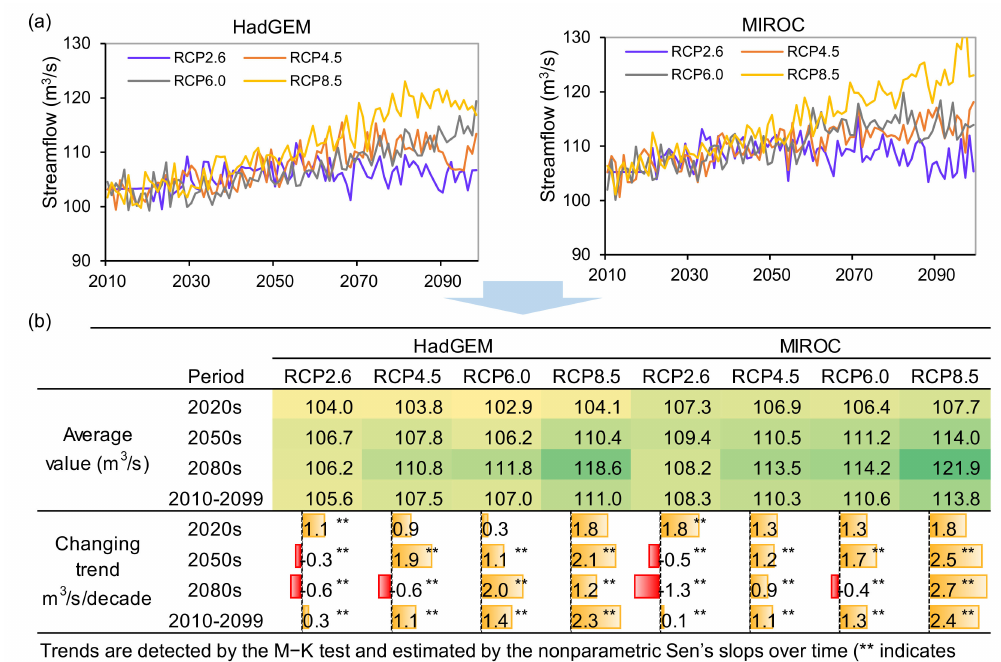
Figure 5. Seasonal precipitation changes compared with the baseline.